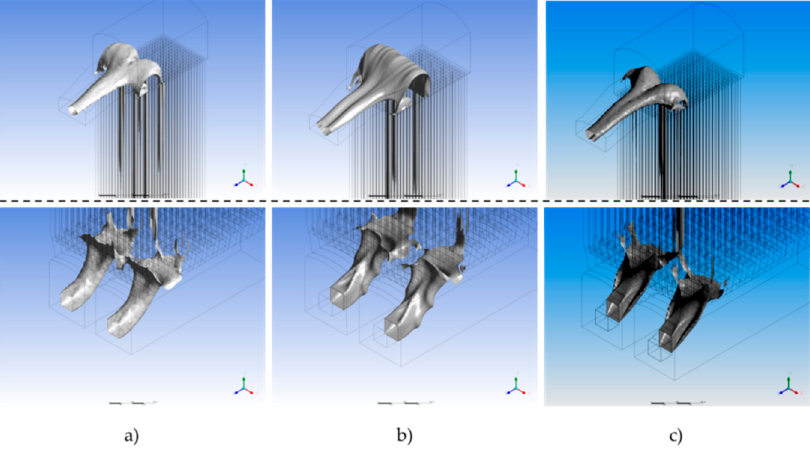
Figure 16. Iso-surface 16% O 2 mass fraction top and bottom—( a ) simple duct ( b ) long duct ( c ) divergent duct.